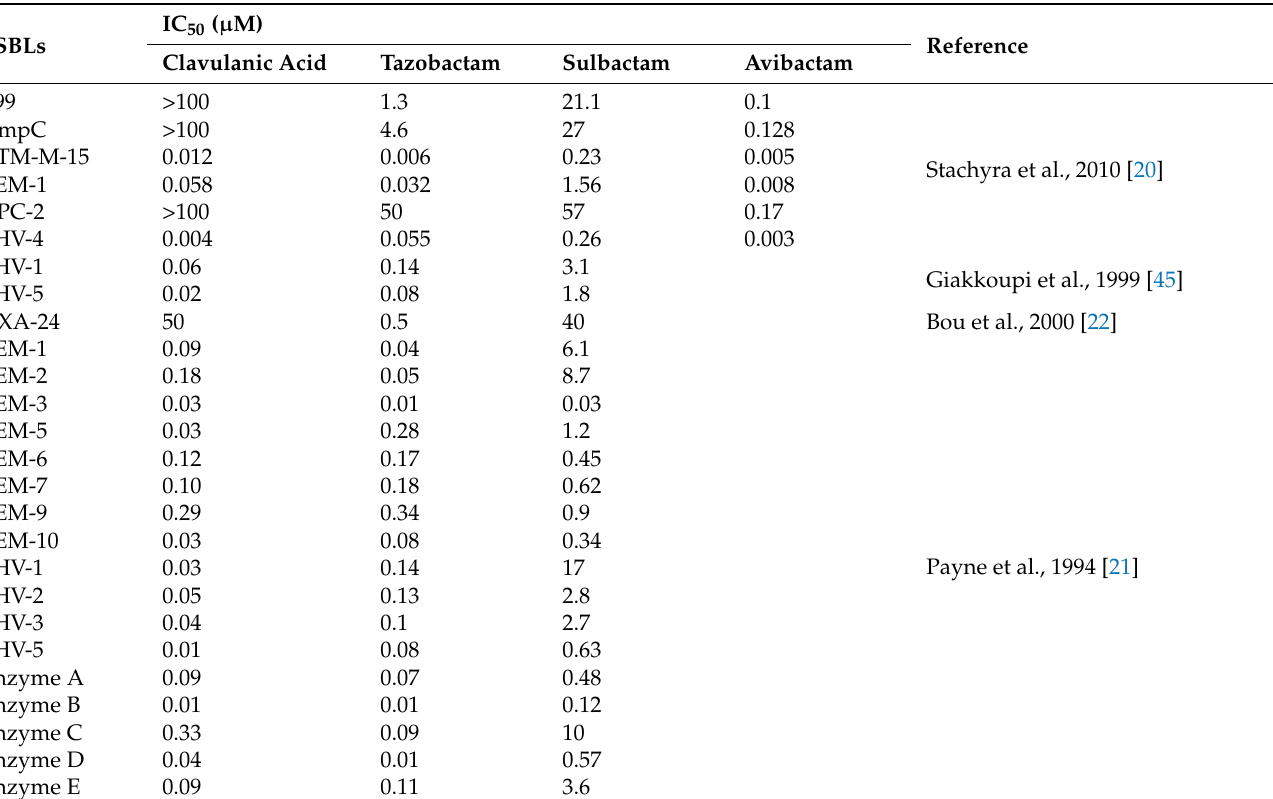
Table 6. IC 50 ( µ M) of clavulanic acid and other β -lactamase inhibitors against ESBLs from the